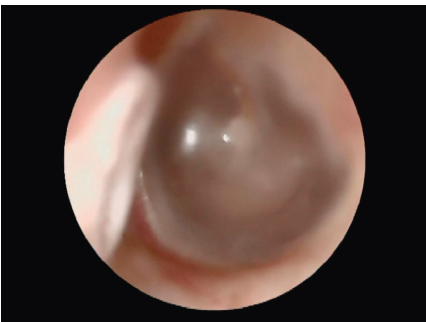
Figure 1: Otoscopy of the left external auditory canal. TMJ gan- glion cyst (deflated) seen in the anterior inferior wall of the left external auditory canal.